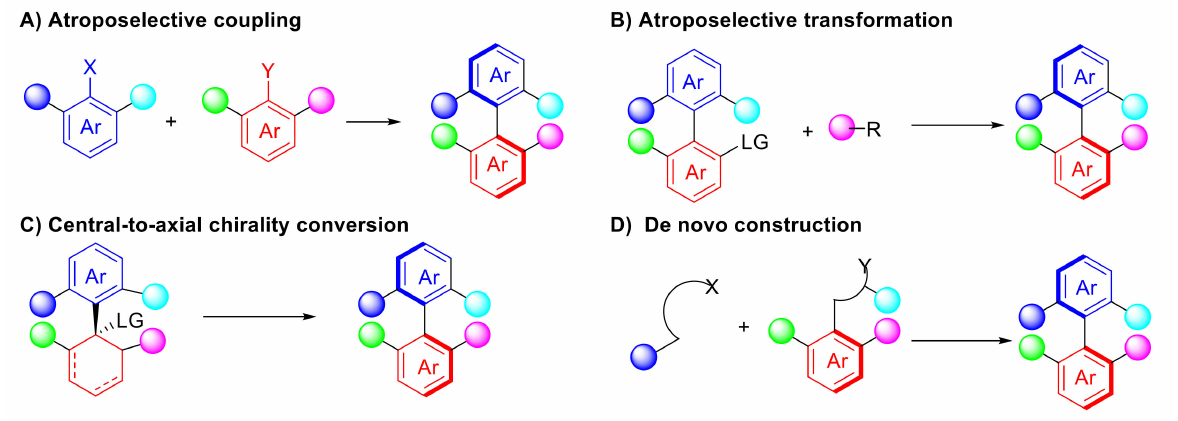
Figure 2. Representative synthesis method toward the heterobiaryl scaffold. Ar = aromatic ring or heteroaromatic ring; LG = leaving